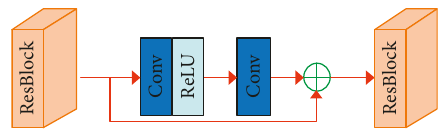
Figure 5: ResBlock architecture consists of two Conv layers and one ReLU